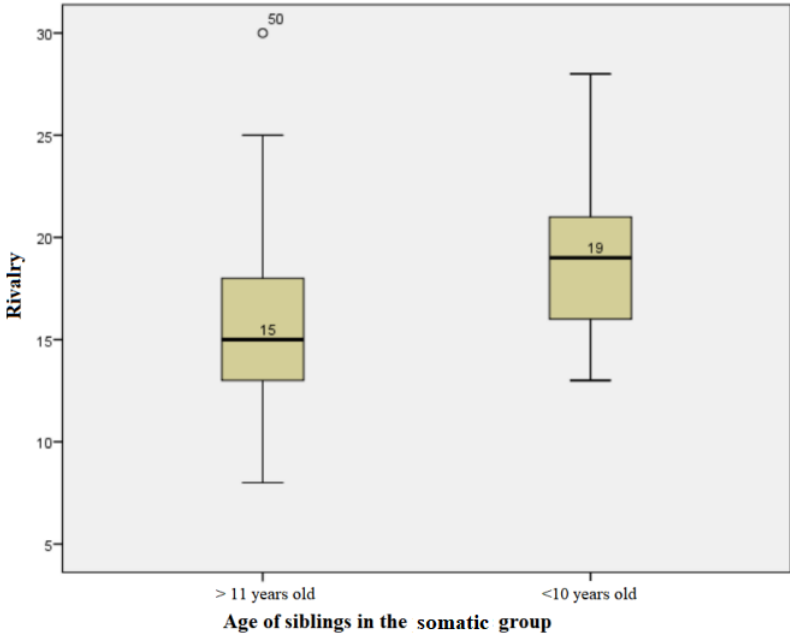
Figure 6. Age influence on rivalry scores in the somatic group.